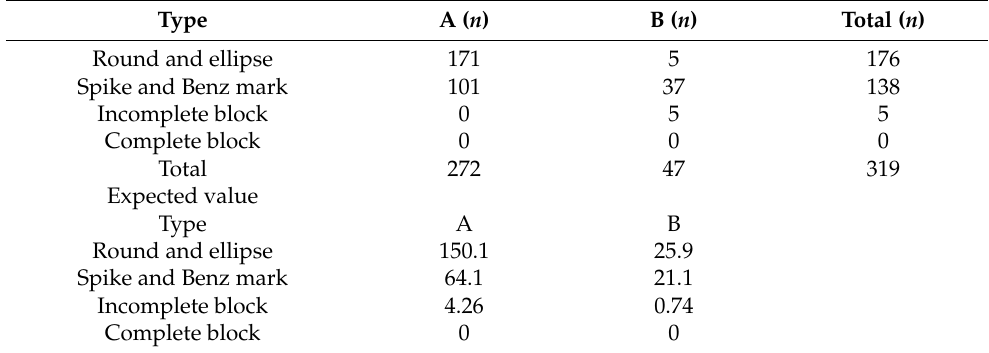
Table 6. CT Epidurography type in Schizas classification Grades A and B (expected value p < 0.001).